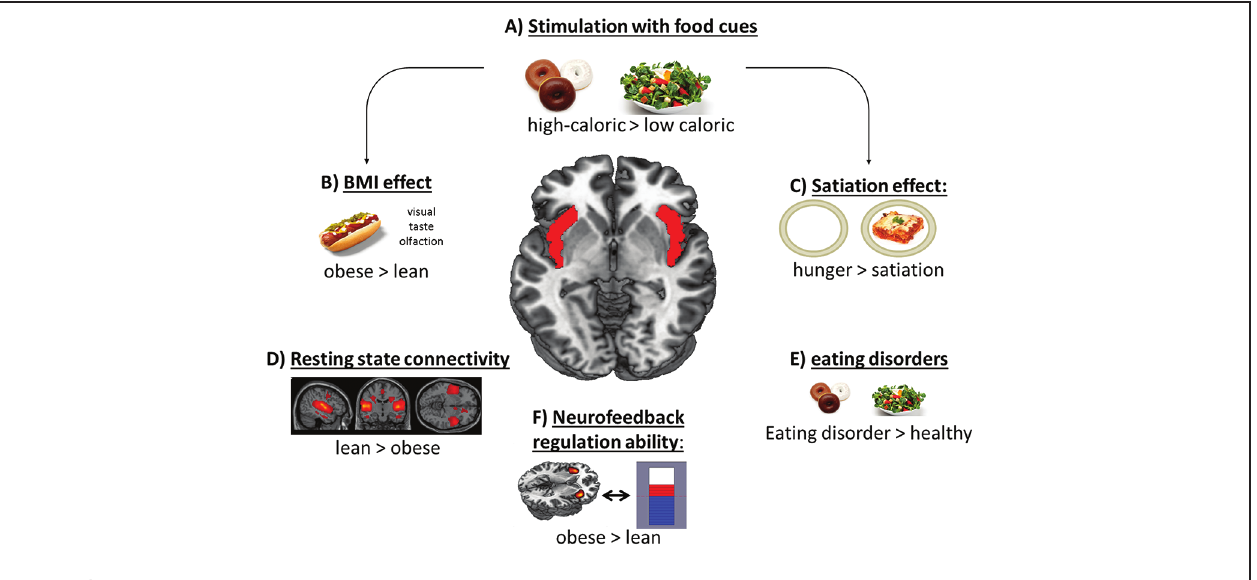
FIGURE 1 | Scheme of the contribution of the insular cortex in food-related processes. Especially the anterior and mid-dorsal part of the insular cortex respond to (A) high-caloric food cues and show (B) increased activation in obese subjects and (C) in a hungry condition after stimulation with food items. (D) Lean subjects showed higher